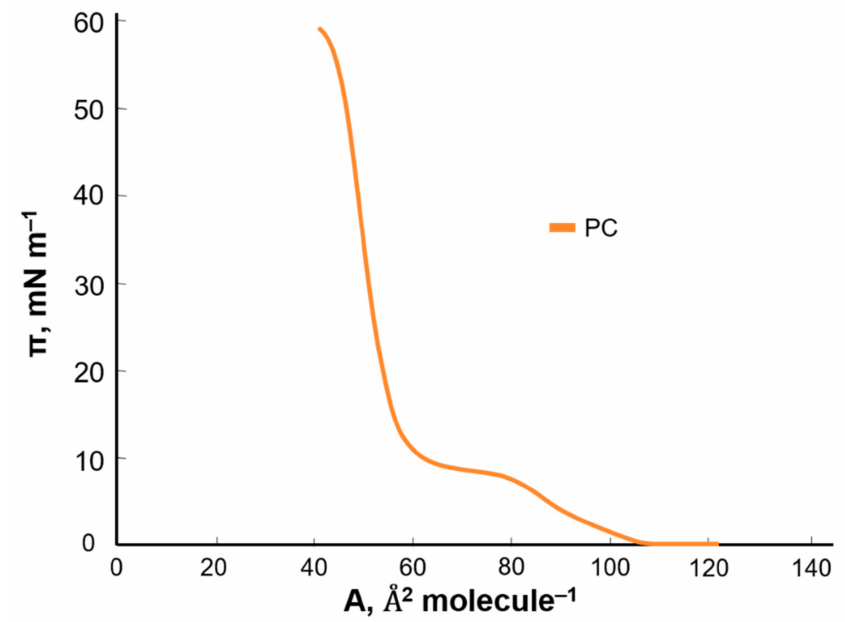
Figure 3. Surface pressure-area ( π –A) isotherms of